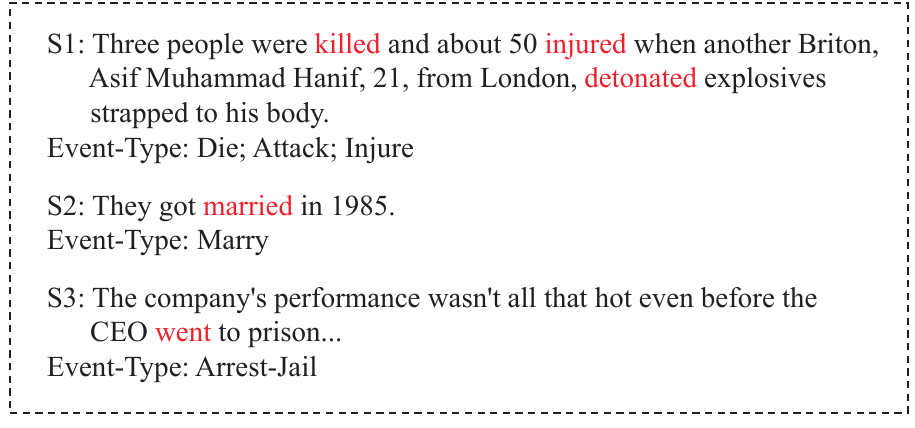
Figure 1. Event instances from the ACE 2005 benchmark, where the trigger words are colored.